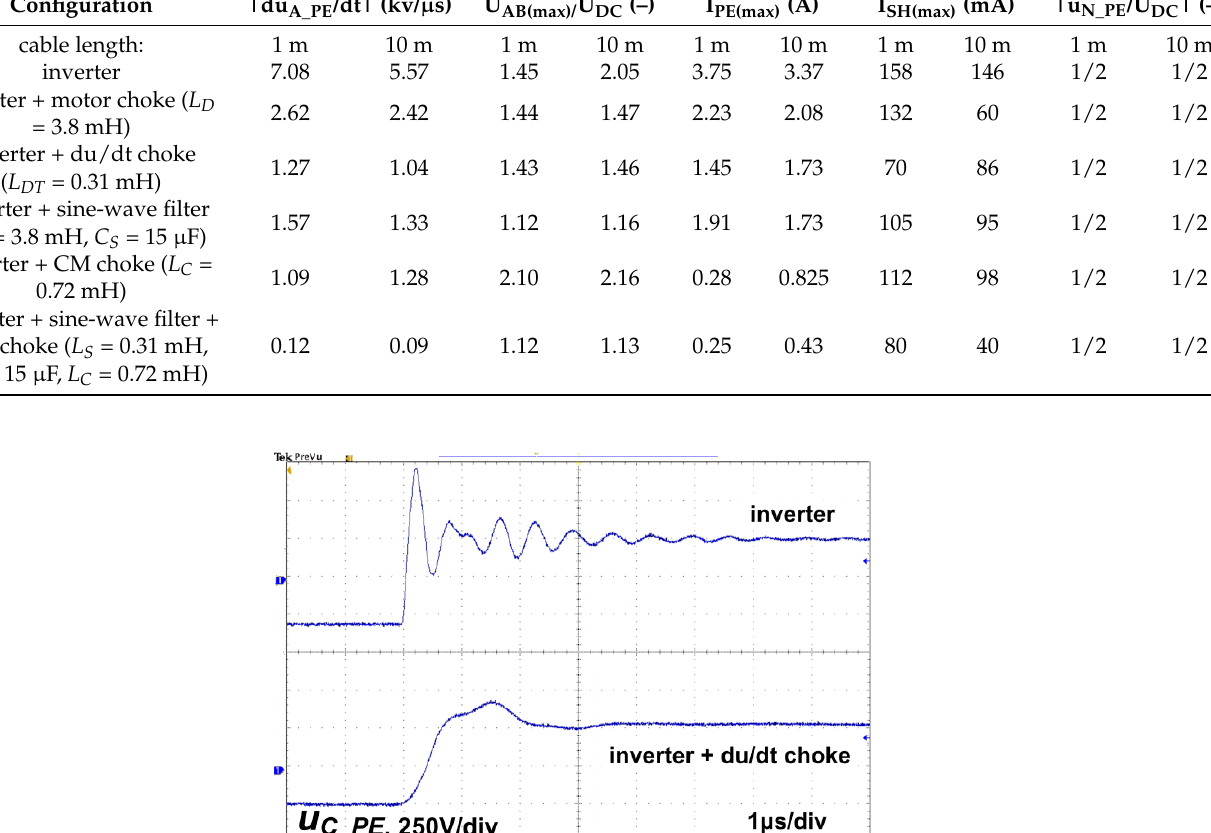
Table 2. Common-mode impedance model parameters of a 7.5 kW motor with hybrid bearings 6308-2RS (ZCS Ceramit). Configuration